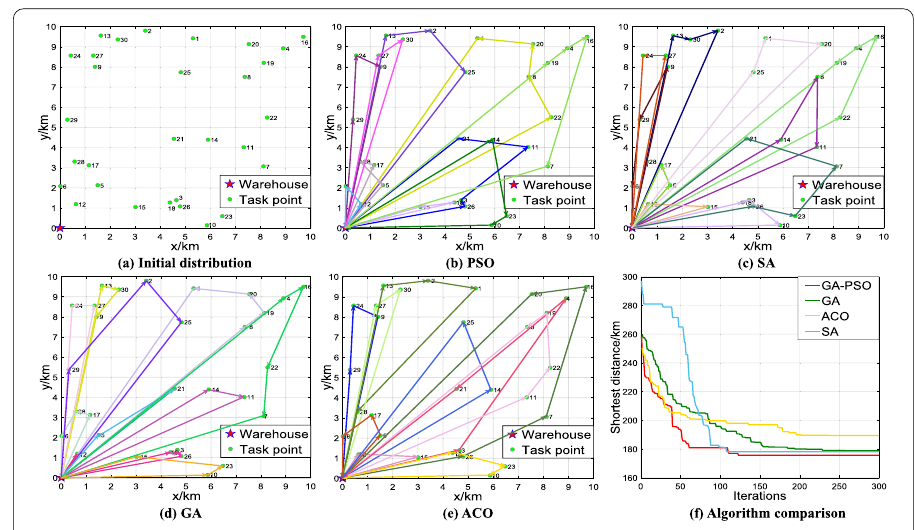
Fig. 7 The results of the third group of the experimental optimal solutions of task allocation